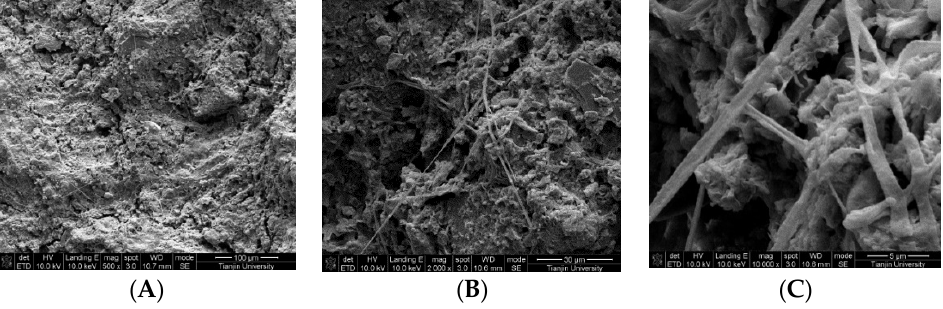
Figure 9. SEM images of zeolite dam matrix at different magnifications: X 500 ( A ); X 2000 ( B ); X 10000 ( C ).